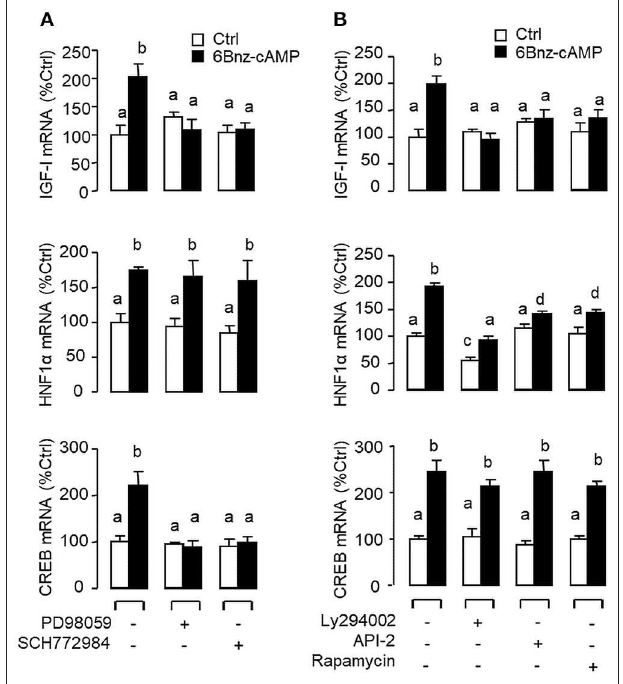
FIGURE 8 | Functional coupling of MAPK and PI3K/Akt cascades with PKA activation in IGF-I, HNF1 α , and CREB mRNA expression at the hepatic level. Carp hepatocytes were exposed to the PKA-specific cAMP analog 6Bnz-cAMP (100nM) for 12h with co-treatment of (A) the MEK 1 / 2 inhibitor PD98059 (10 µ M) or ERK 1 / 2 inhibitor SCH772984 (10nM), or (B) the PI3K inhibitor Ly294002 (10 µ M), Akt blocker API-2 (2 µ M), or mTOR inactivator Rapamycin (20nM). After drug treatment, total RNA was isolated from individual wells and used for real-time PCR with primers for IGF-I, HNF1 α , and CREB,